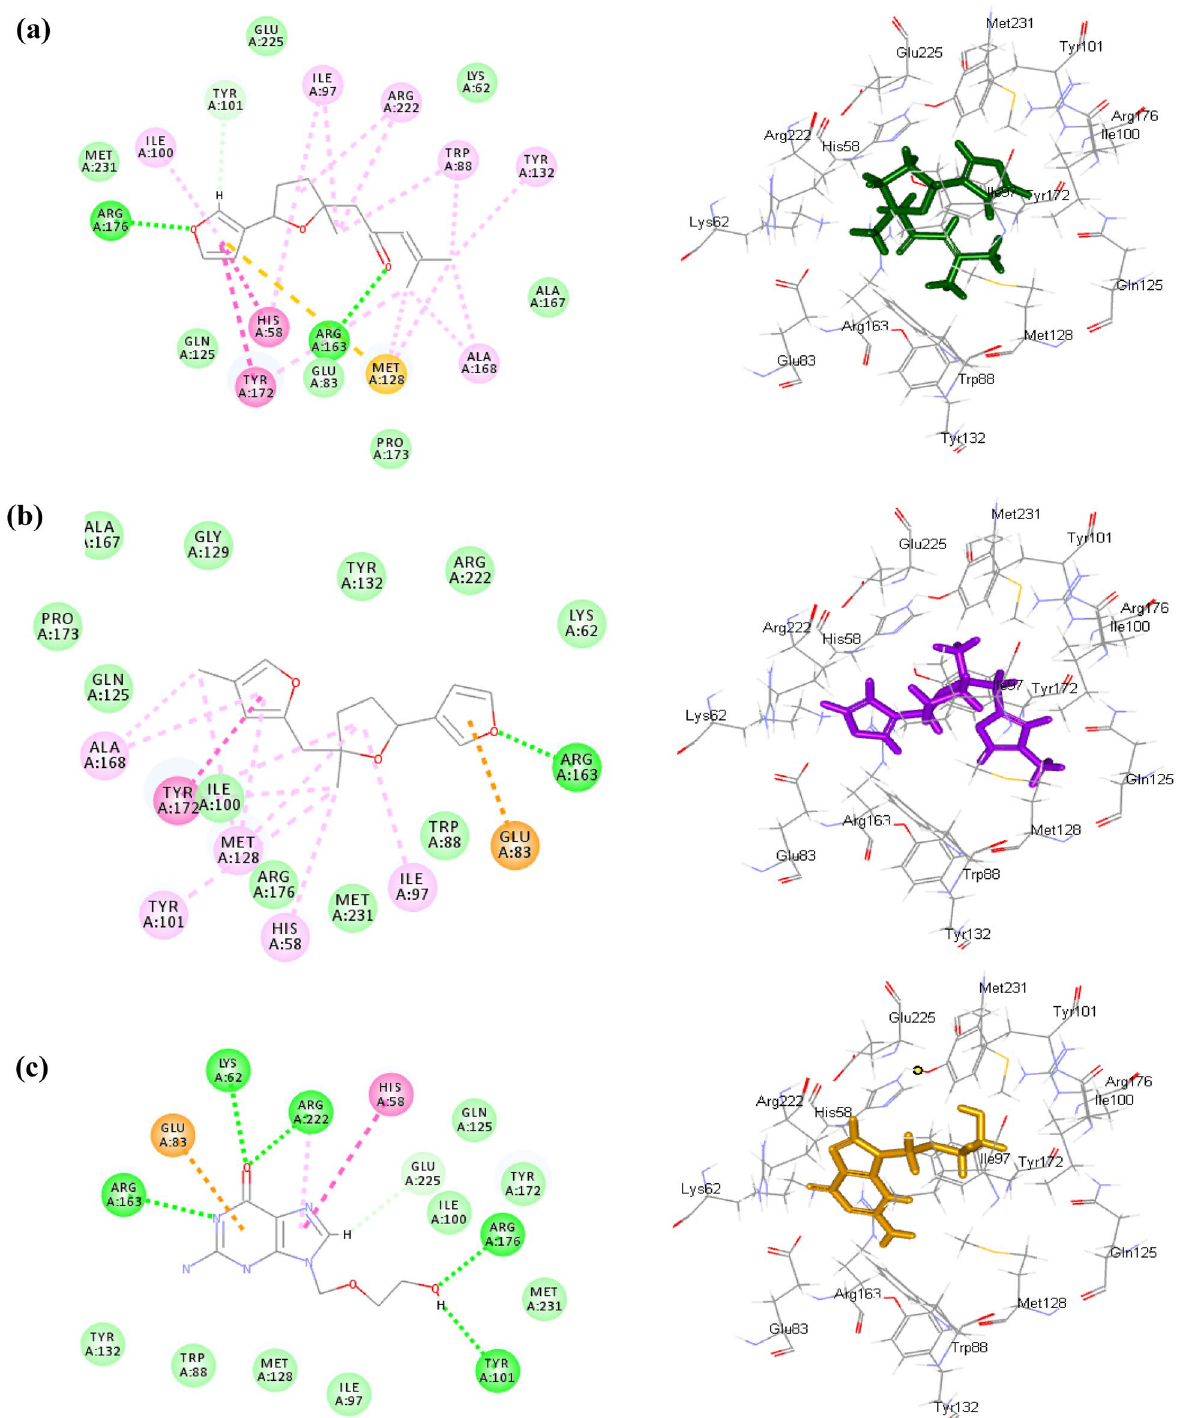
Figure 4. 2D and 3D interactions of dehydroepingaione ( a ), 2,3’-bifuran, 2,3,4,5-tetrahydro-5-methyl-5-[(4- methyl-2-furanyl)methyl] ( b ) and acyclovir ( c ) in the active site of HSV type-1 thymidine kinase